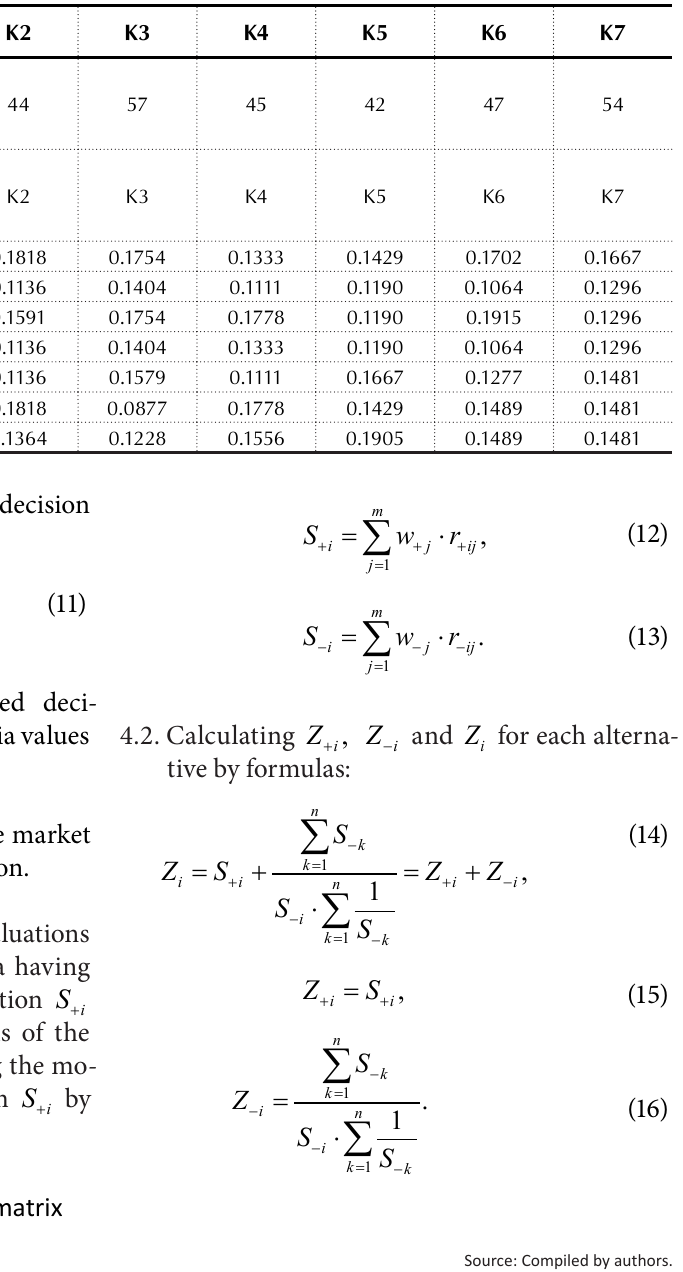
Source: Compiled by authors.